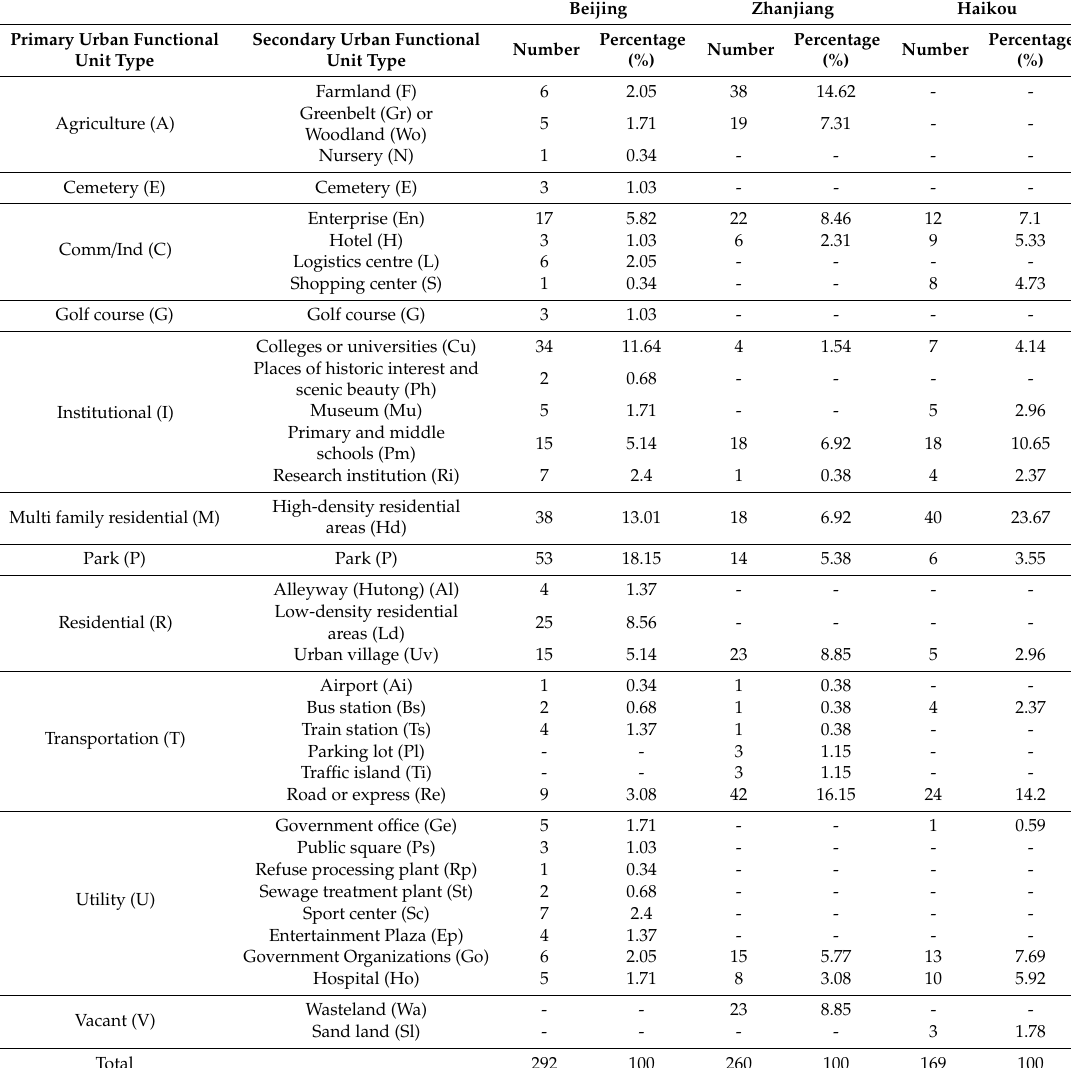
Table 2. The numbers and percentages of primary and secondary urban functional units within Beijing, Zhanjiang, and Haikou based on the Urban Forest E ff ects (UFORE)